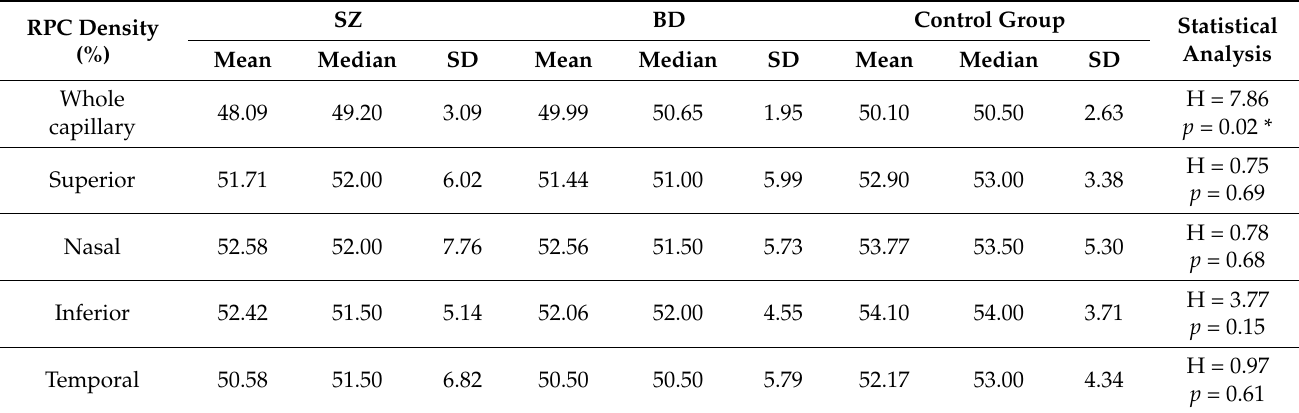
Table 1. Radial peripapillary capillary (RPC) density (%) in the peripapillary area in the eyes of the SZ and BD patients and in the control group.